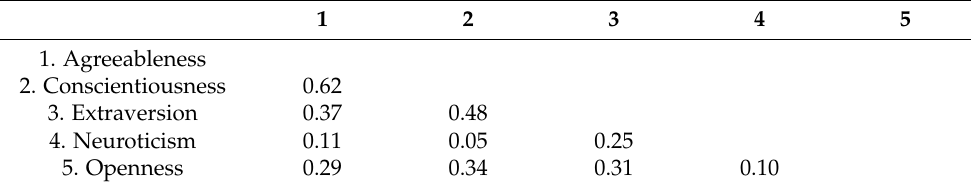
Table 3. Discriminant validity measured by HTMT (the Big Five Inventory-Short Version). (The HTMT is the mean value of the indicator correlations across constructs relative to the mean of the average correlations for the indicators measuring the same construct